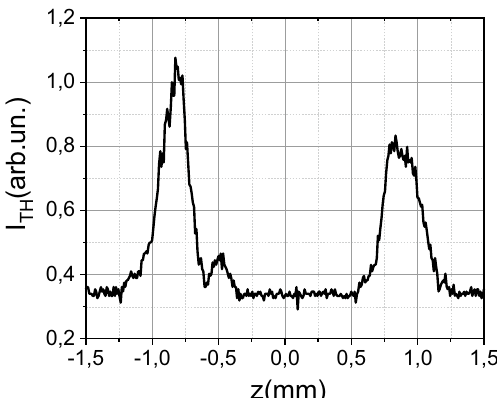
Figure 7. ( a ) The third harmonic profile during the movement of the sample along the optical